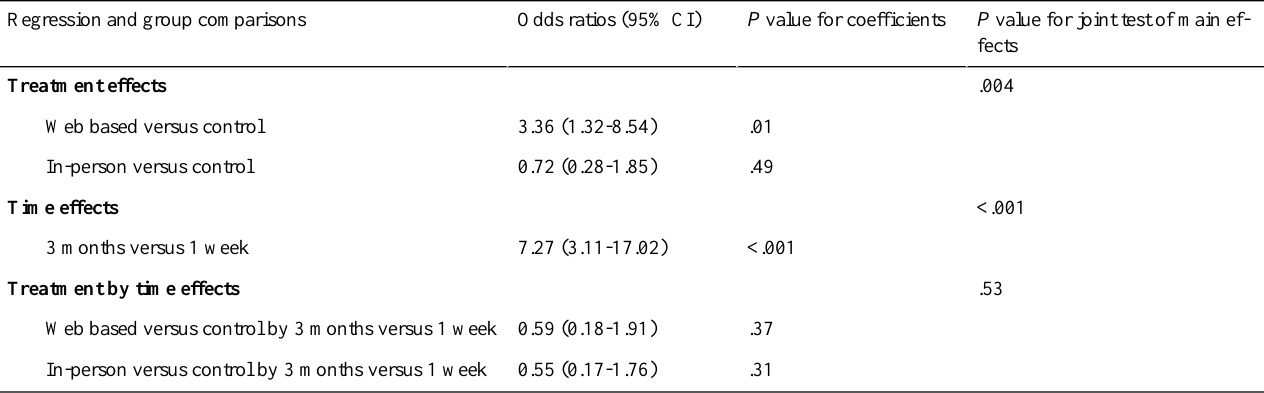
Table 4. Results of the mixed effects regression analysis for goal attainment by treatment condition and time.